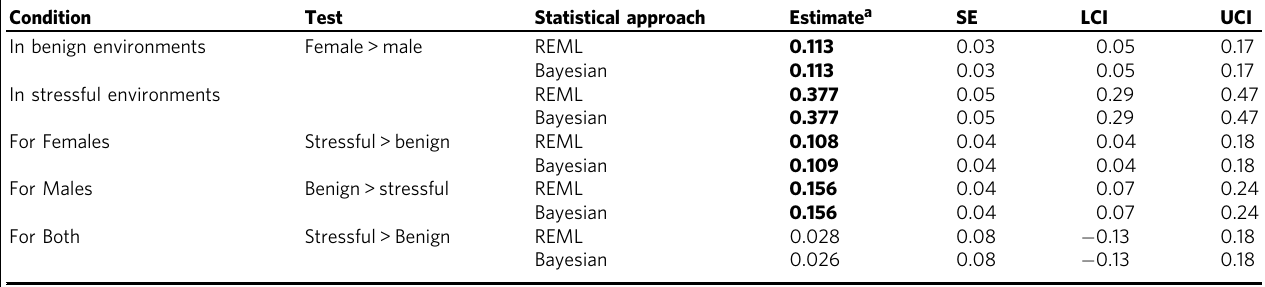
Table 2 Hypothesis tests showing how sex and environmental stress interact to modulate effect size